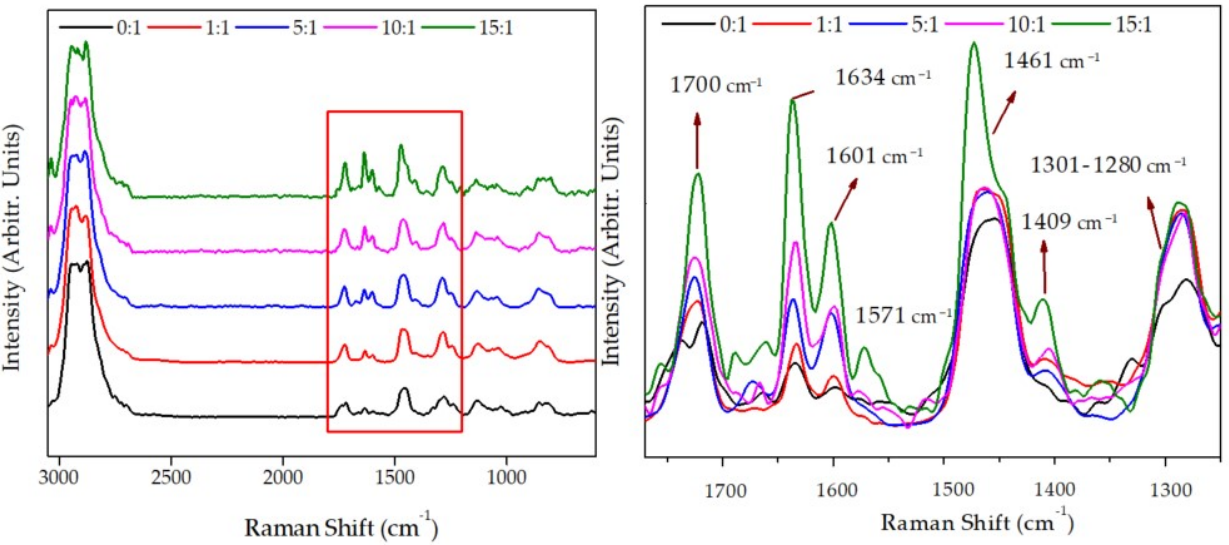
Figure 2. Raman spectra of net-poly (AAc- co -PEGDA 575 ) at a different mole ratio, i.e., AAc:PEGDA 575 of 0:1, 1:1, 5:1, 10:1, and